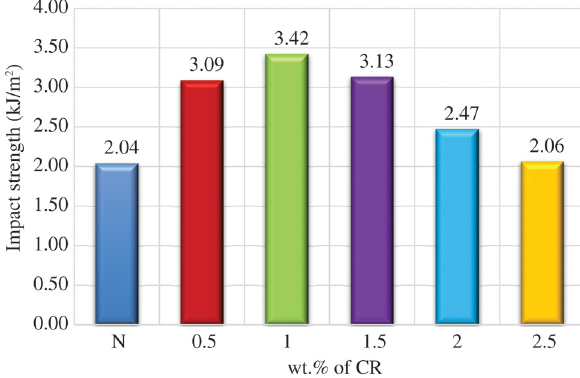
Figure 24: Variation of impact strength for various compositions of CFR.